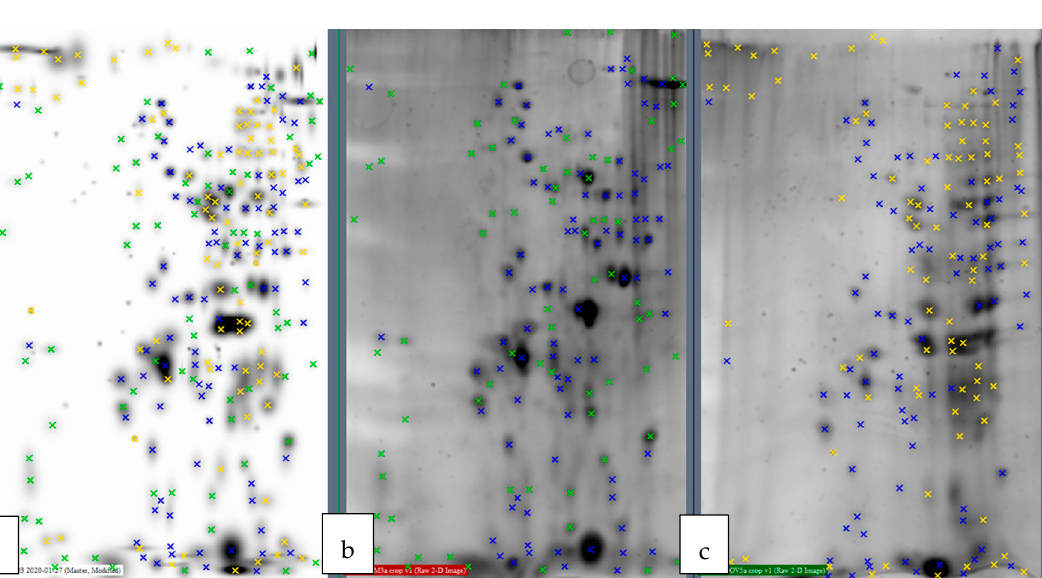
Figure 3. Spot comparison after 2D gel electrophoresis using the PDQuest TM 8.0.1. Analysis Software (Bio-Rad, Hercules, CA, USA). (a) Both gels overlapped; ( b ) Gel corresponding to 12B3-5; (c) Gel corresponding to 0V5-2. Green crosses show 12B3-5-specific spots; yellow crosses show 0V5-2-specific spots; blue crosses show spots that are common to both